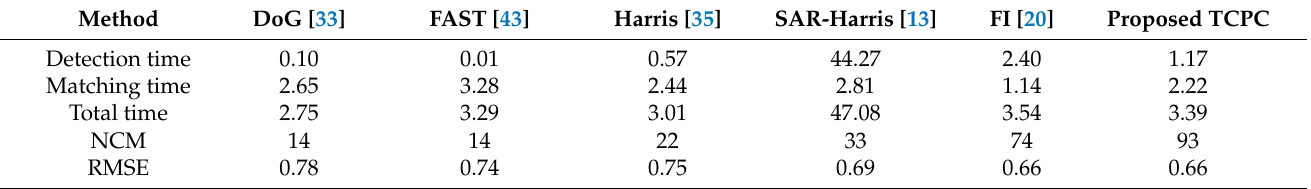
Table 6. Quantitative comparison of feature descriptor matching with different keypoint